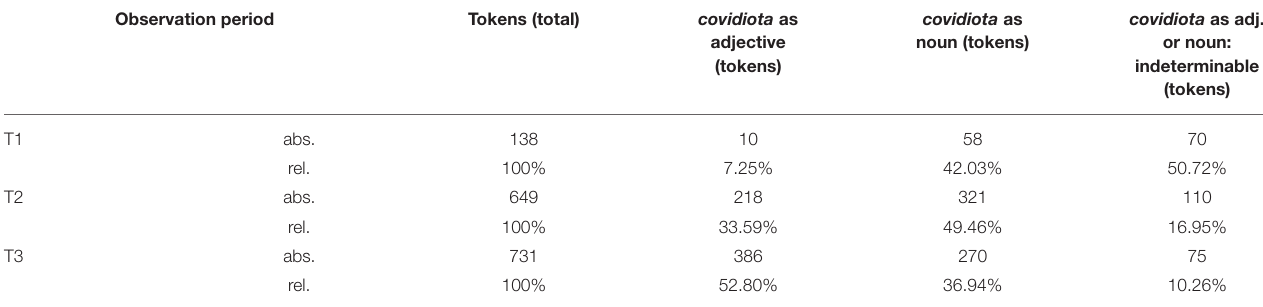
TABLE 6 | Isolation of covidiota in the Spanish sentence. Observation period